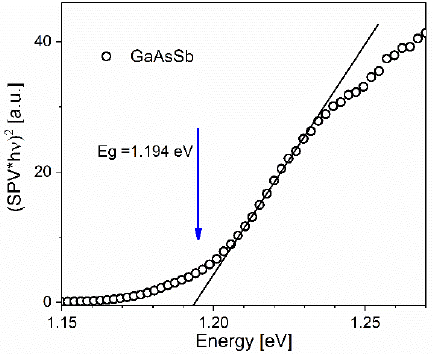
Figure 4. Tauc plot of the SPV spectrum of GaAsSb.